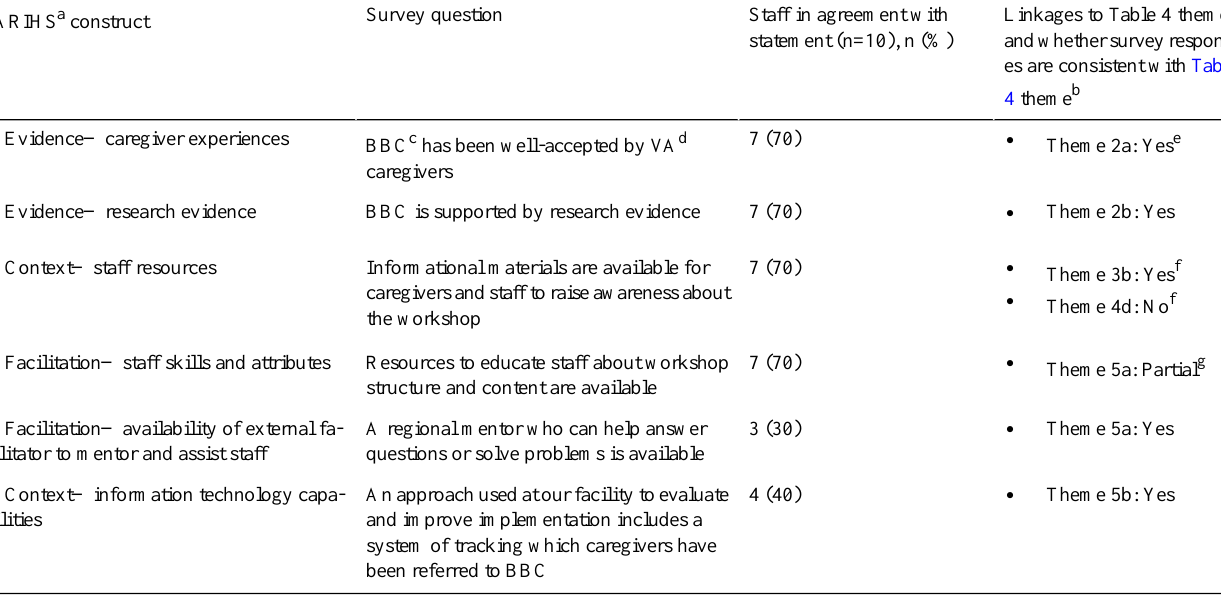
Table 3. Local staff survey results according to Promoting Action on Research Implementation in Health Services